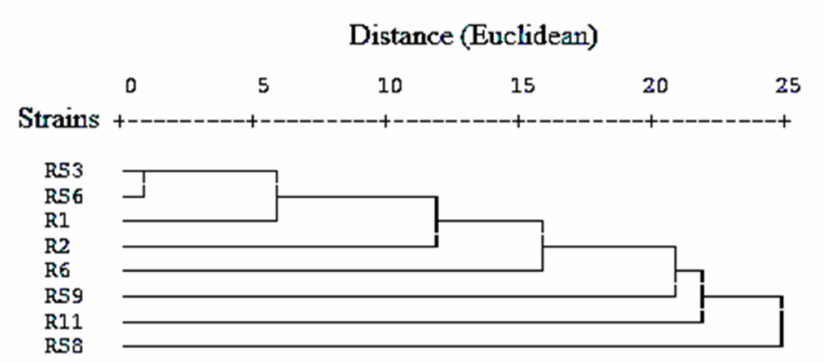
Figure 2. Hierarchical cluster analysis (between groups linkage) measuring the squared Euclidean distance based on their C and N utilization pattern.